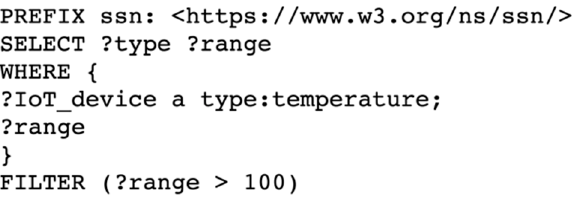
Figure 6. SPARQL query generated by IoT device query sub-service to support automatic discovery of IoT devices.